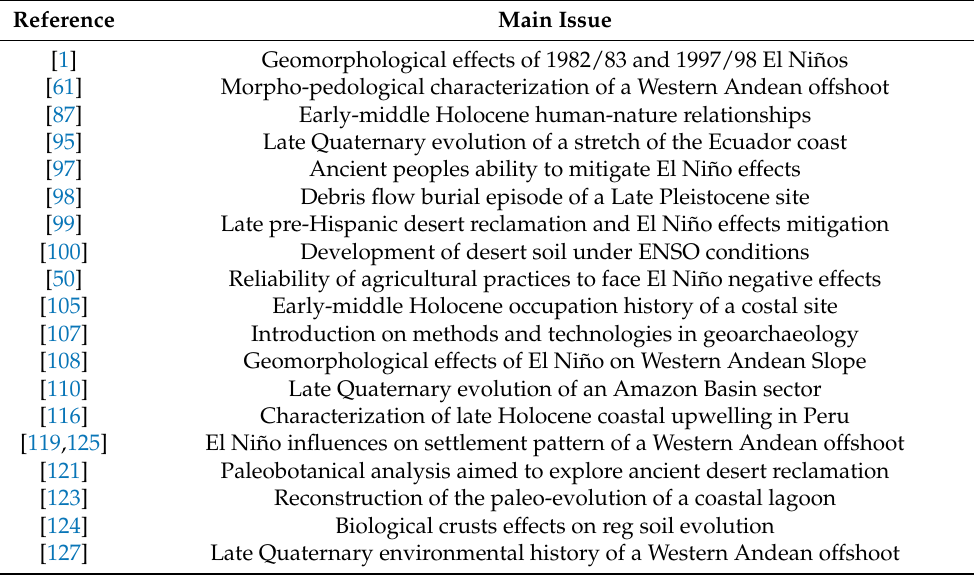
Table A1. Works whose full text was analyzed with no data useful for the objective of the